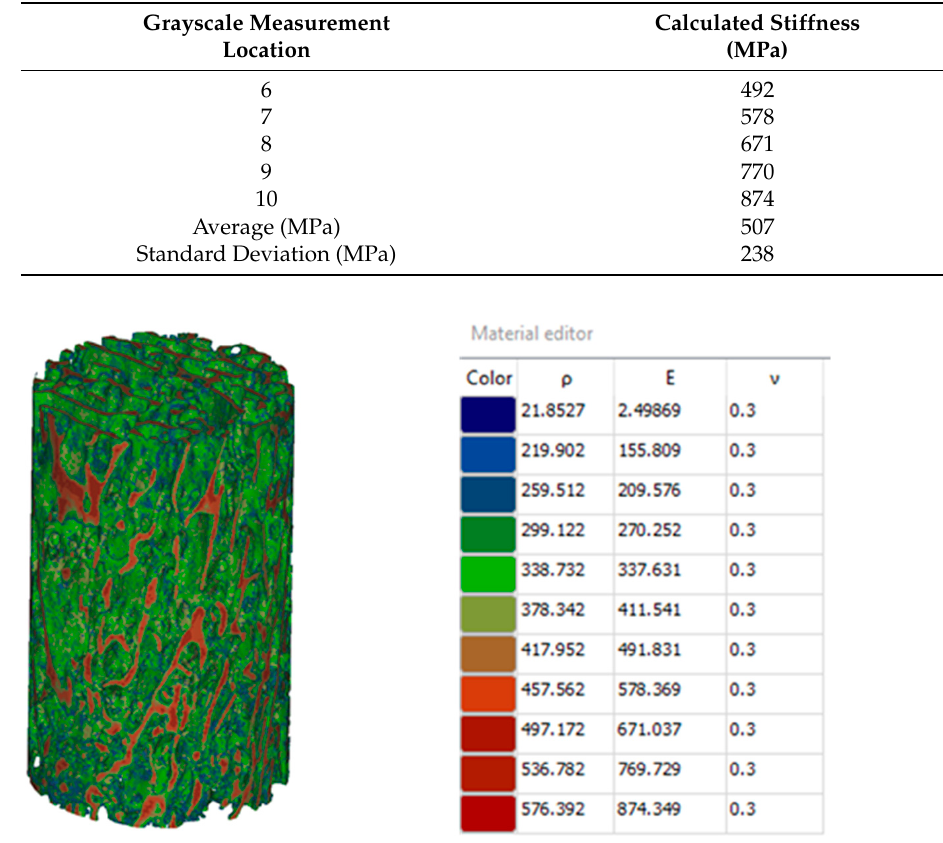
Figure 10. Bone Stiffness Properties (MPa) Assigned Based on the Gray Scale Values. Table 5. Bone Stiffness Properties.